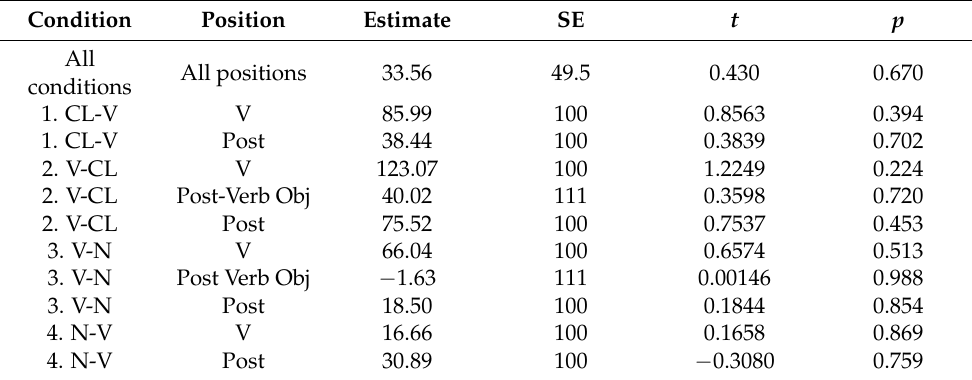
Table 4. Response times: simple effects by group.